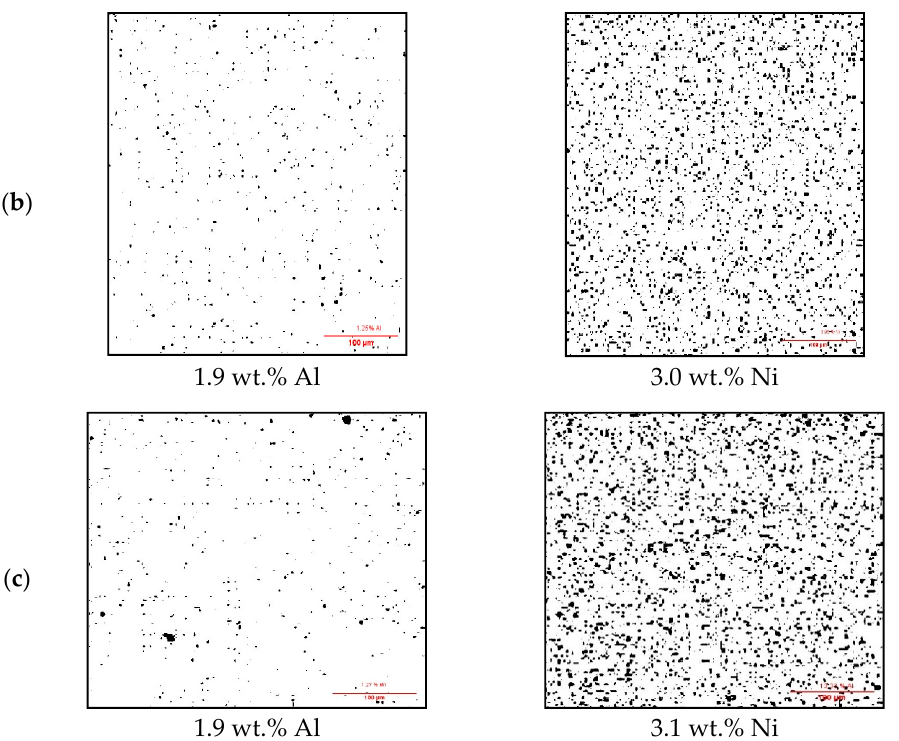
Figure 10. Elemental mapping for ( a ) As-received Cu CC from used batteries, ( b ) Cu CC from recycled batteries after melting, and ( c ) Cu CC from recycled batteries after reuse and cycling.